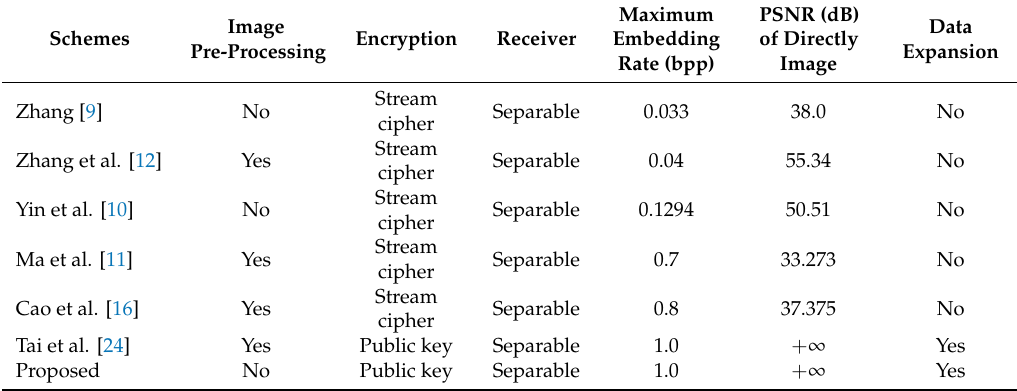
Table 3. Scheme-wise property